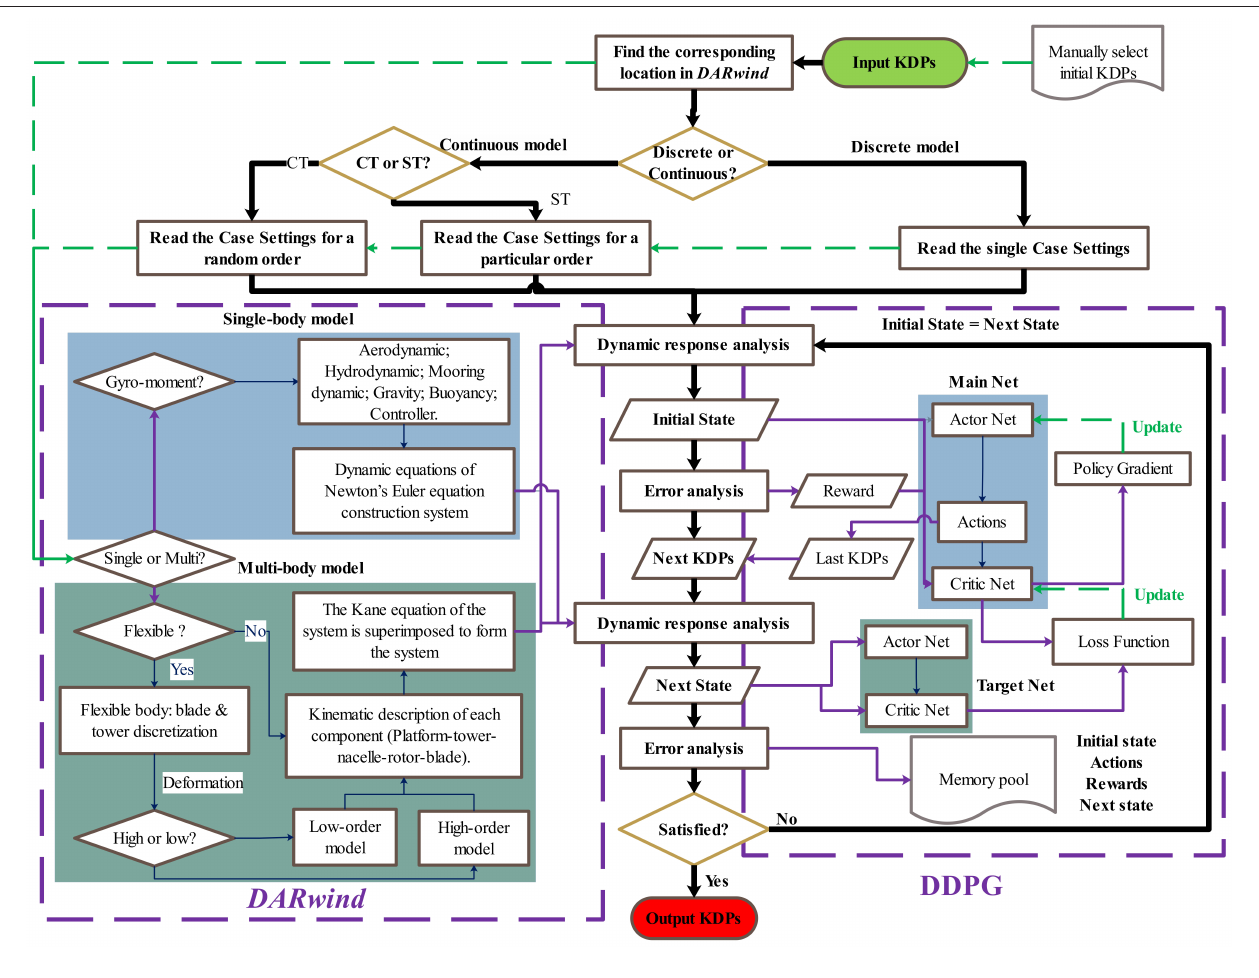
FIGURE 2 | The flowchart of